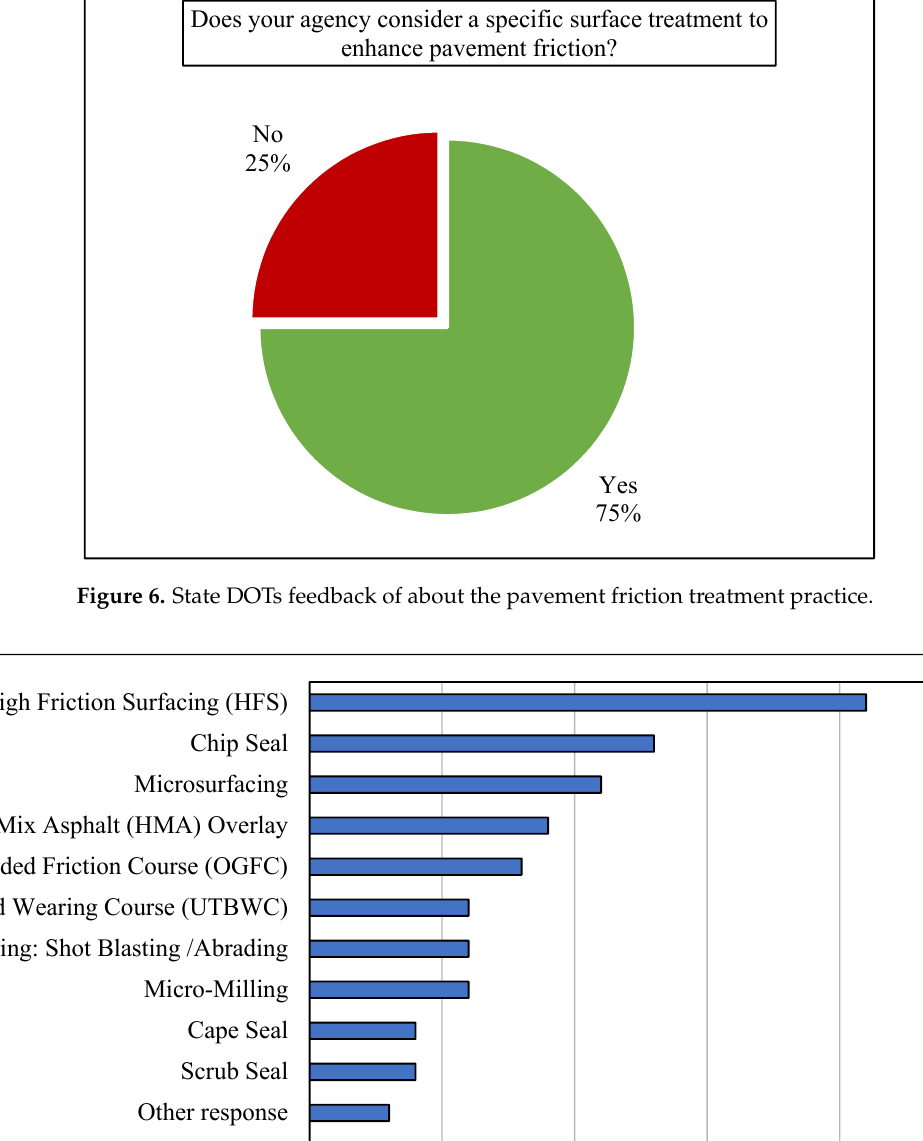
Figure 6. State DOTs feedback of about the pavement friction treatment practice.